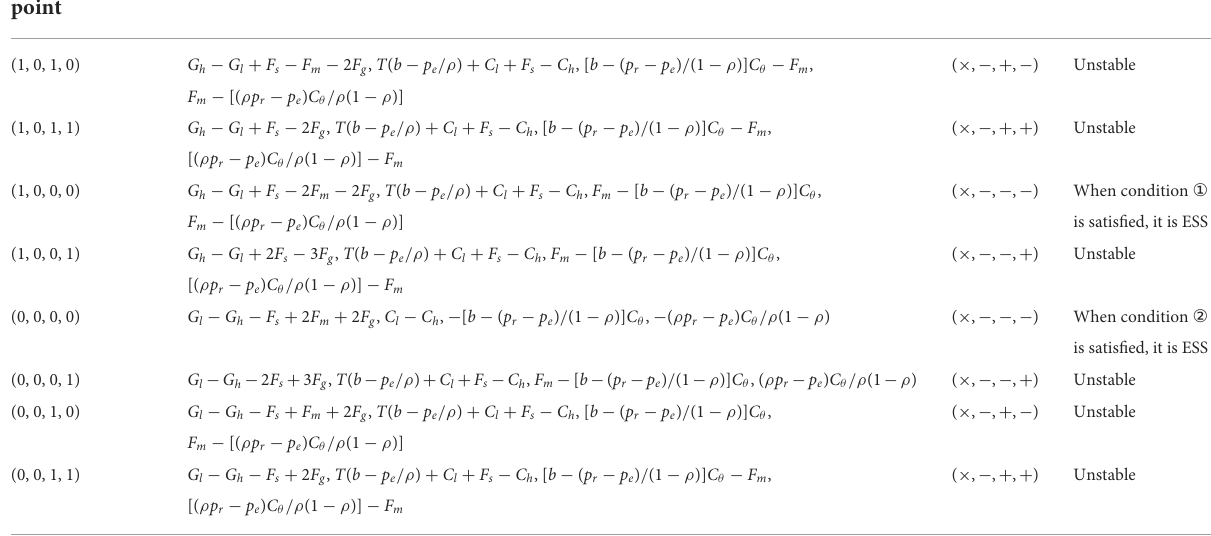
TABLE 4 Asymptotic stability of the equilibrium point in providing low-quality drugs. Equilibrium Eigenvalues λ 1 , λ 2 , λ 3 , λ 4 Sign point